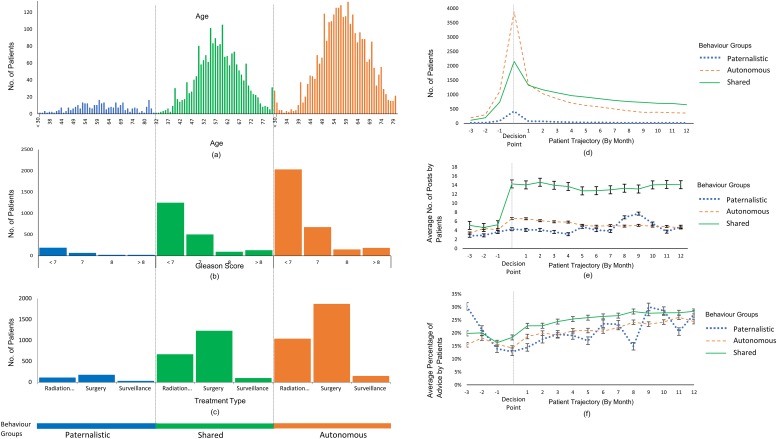
PRIME extracts multiple modalities of information individually for each patient from OSG discussions.This individual information is grouped into corresponding decision-making behaviour; Paternalistic, Autonomous and Shared groups by (a) patient age, (b) Gleason score and (c) treatment type. PRIME further generates aggregated trajectories for multiple temporal aspects of each decision-making behaviour group, before and after the decision, (d) number of patients engaged in OSG discussions, (e) average number of posts and (f) average percentage of posts containing advice by each group. The decision point is indicated by dotted vertical line in d-f.